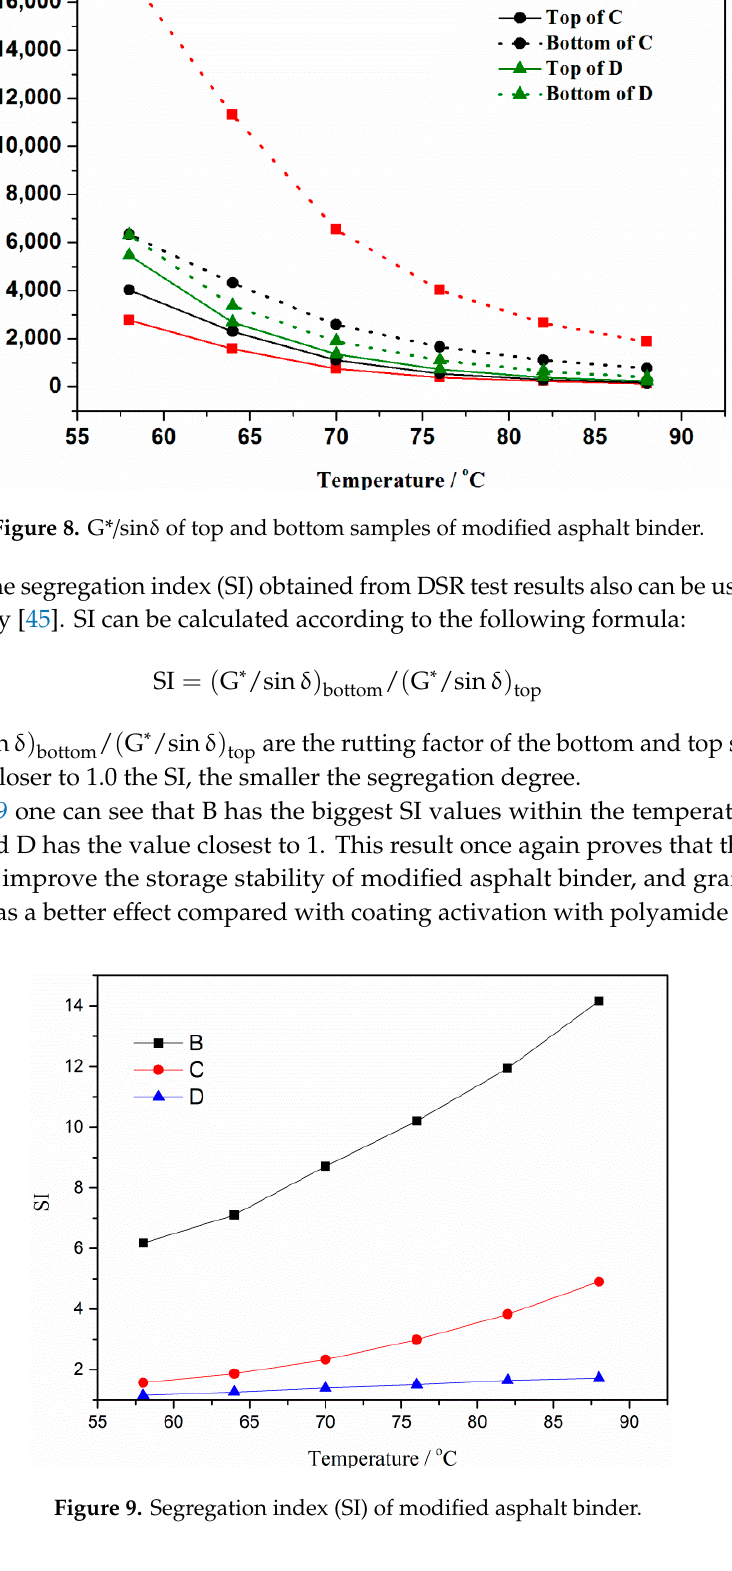
Figure 9. Segregation index (SI) of modified asphalt binder .